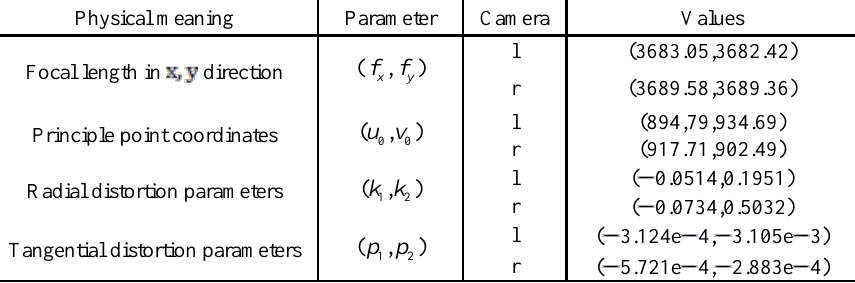
Table 1. Intrinsic parameters of left and right